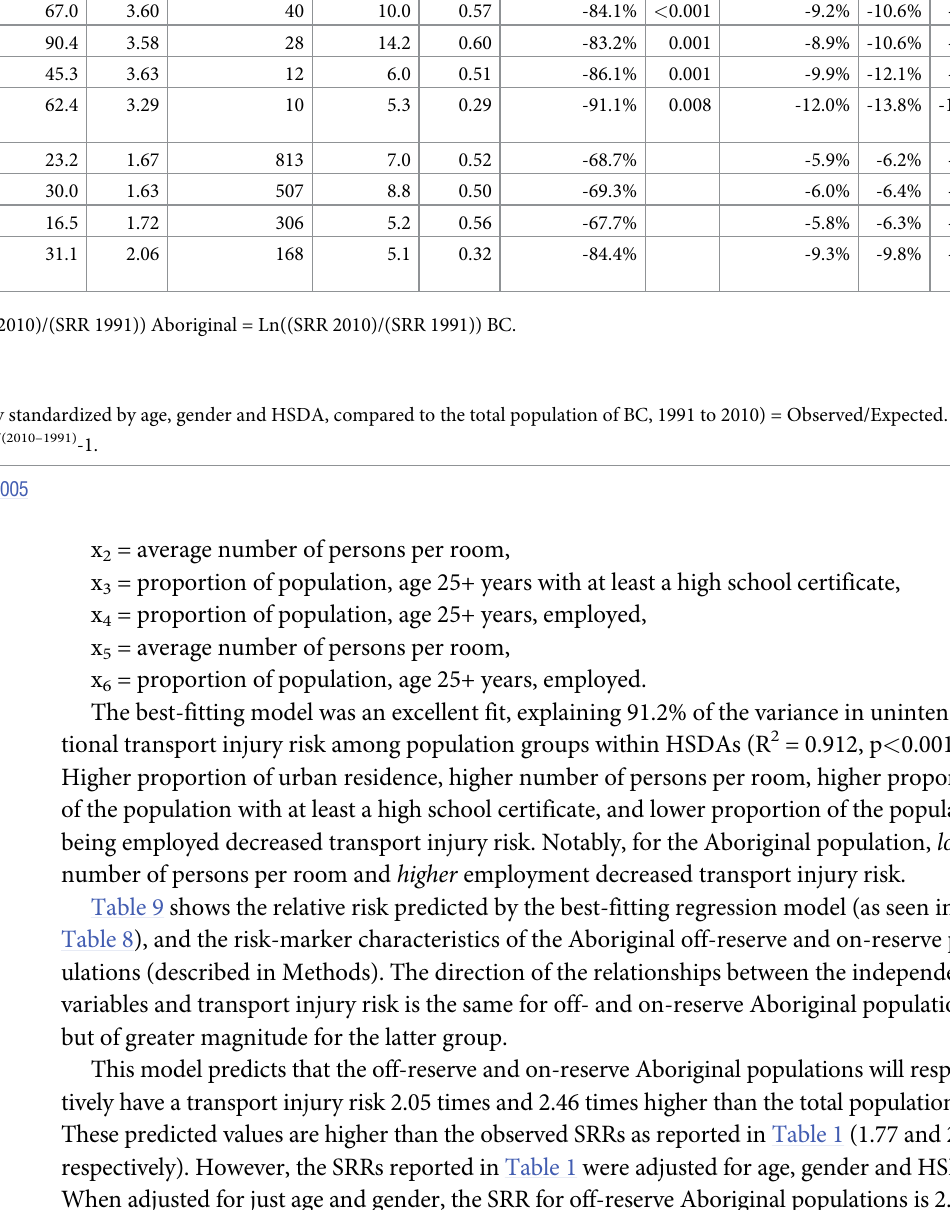
Table 5. Standardized relative risks of hospitalization for unintentional transport injury, British Columbia, 1991–2010. Demographic